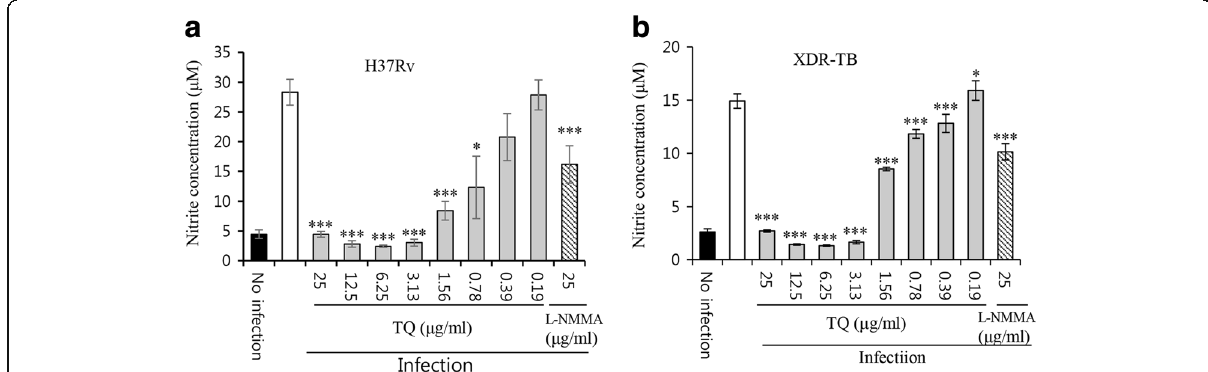
Fig. 2 Modulation of MTB-induced NO production by TQ in M. Tuberculosis -infected macrophages. Raw 264.7 macrophages were infected with H37Rv and XDR-TB for 2 h at an MOI of 1:10 at 37 °C with 5% CO 2 , followed by drug treatment for 3 days. Nitric oxide ( μ M) was measured using Griess reagent. a Effect of TQ on nitric oxide production in H37Rv-infected Raw 264.7 cells. b Effect of TQ on nitric oxide production in XDR-TB- infected Raw 264.7 cells. Data represent the mean ± SD of 3 independent experiments done in triplicate. * P < 0.05, ** < 0.01, *** < 0.009 by Student ’ s